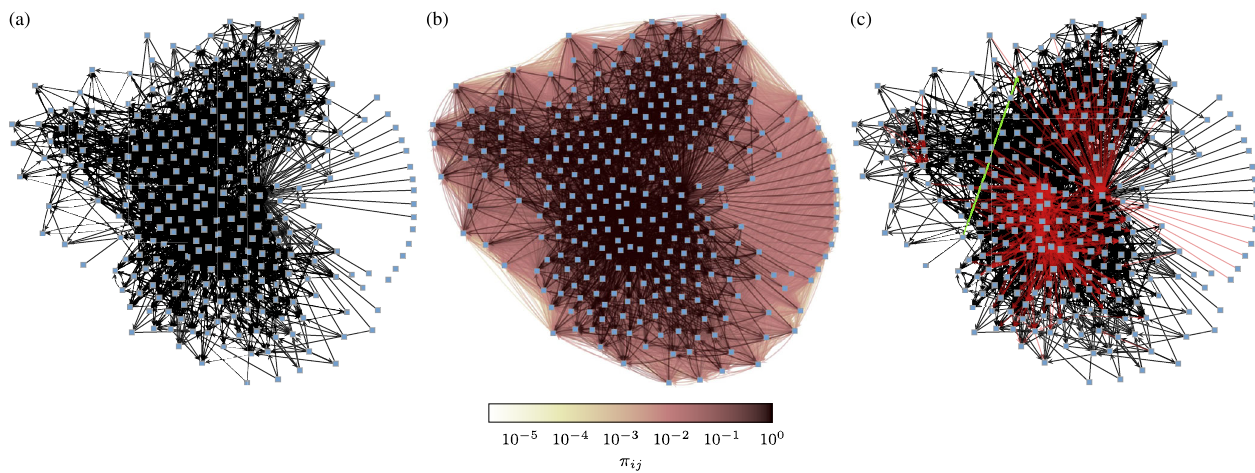
FIG. 9. (a) Measured neural network of the C. elegans worm [39]. (b) Marginal posterior distribution π ij of the edges according to our reconstruction method, shown as edge colors. (c) MMP estimate of the network, with inferred missing edges shown in red and spurious edges shown in green.